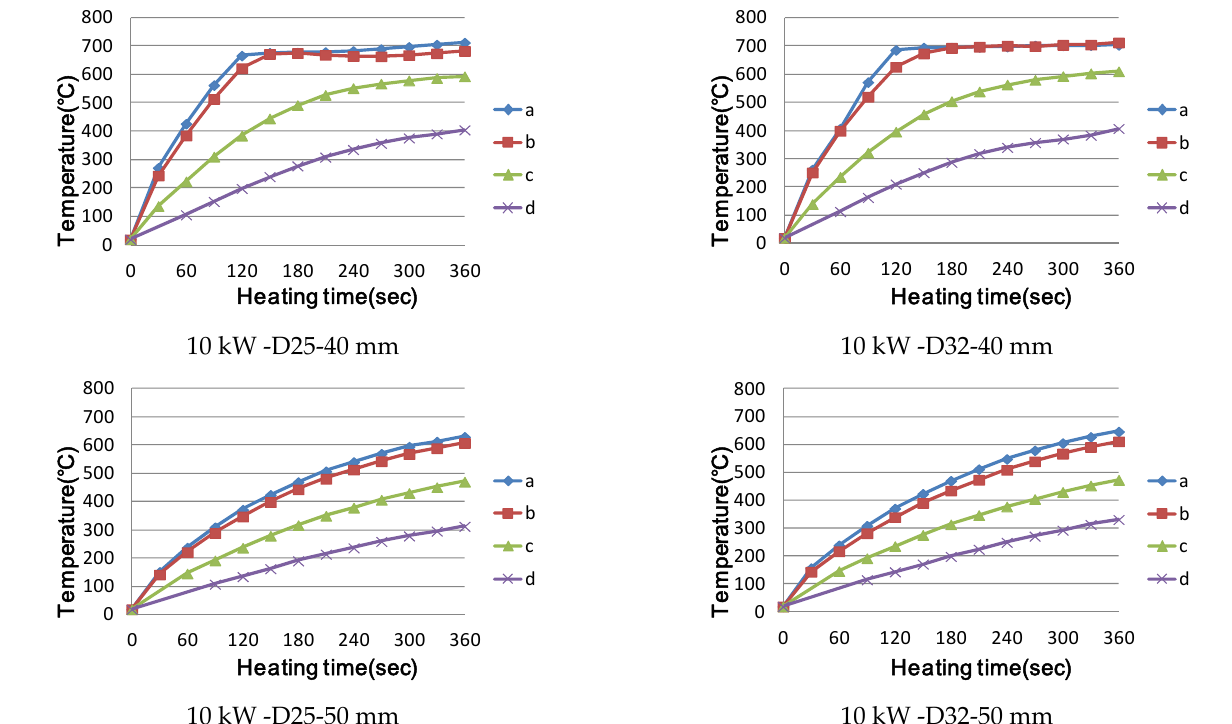
Figure 11. Temperature distribution of reinforcing bar by induction heating (10 kW-430 mm). Rebar surface temperatures a, b, c, and d = 0 mm, 30 mm, 60 mm, and 90 mm from the center of reinforcement, respectively.